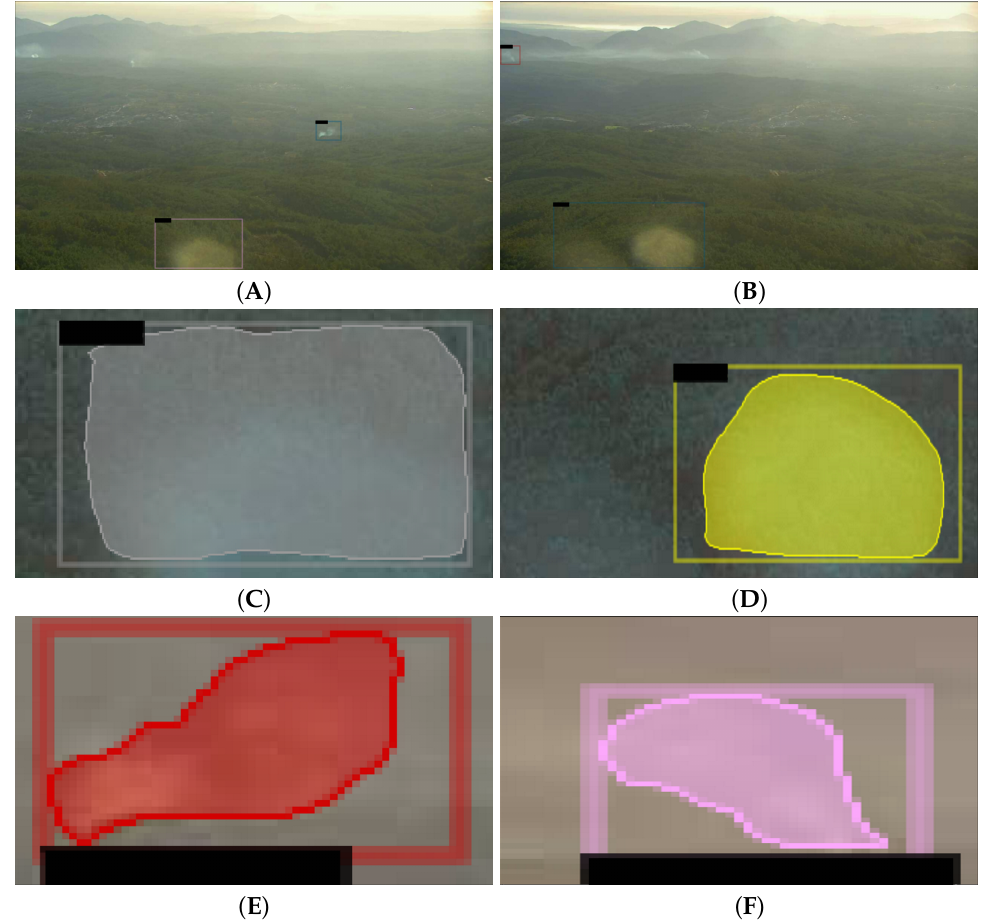
Figure 5. Examples of true and false positives detected and their segmentation outlines. Figure ( A ) shows two detected (with the object detection algorithm) bounding box of a hrz smoke column and the respective segmentation in ( C , E ). The object (detected with 69.1%) in ( C ) was later correctly rejected (with the machine learning algorithm) as a smoke object with a probability of 21.3%, while object (detected with 90.9%) in ( E ) was correctly identified as smoke with a probability of 96.2%. Figure ( B ) shows another double detection of hrz objects, and the respective segmentation in ( D , F ). The object (detected with 85.0%) in ( D ) was later incorrectly detected as a smoke object with a probability of 84.4%, while the object (detected with 96.9%) in ( E ) was correctly identified as smoke with a probability of